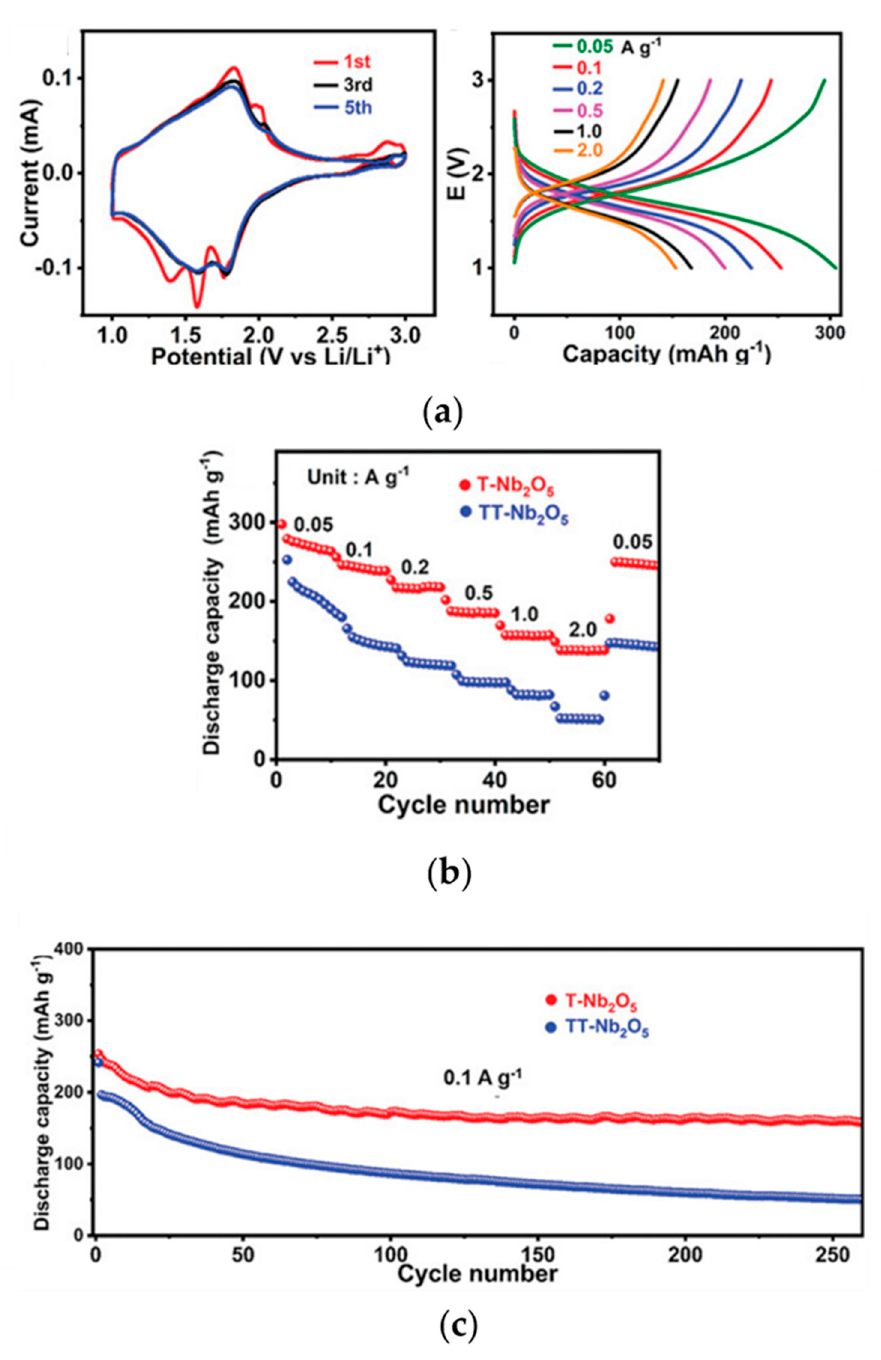
Figure 3. ( a ) Cycling Voltammetry (CV) curves (0.1 mV s − 1 ) (left panel) and galvanostatic charge– discharge plots at various current densities of T-Nb 2 O 5 nanorods (NRs, right panel); ( b ) rate behaviors of T-Nb 2 O 5 ; ( c ) Cycling properties of T-Nb 2 O 5 and TT-Nb 2 O 5 NRs at 0.1 A g − 1 . Adapted from [52].